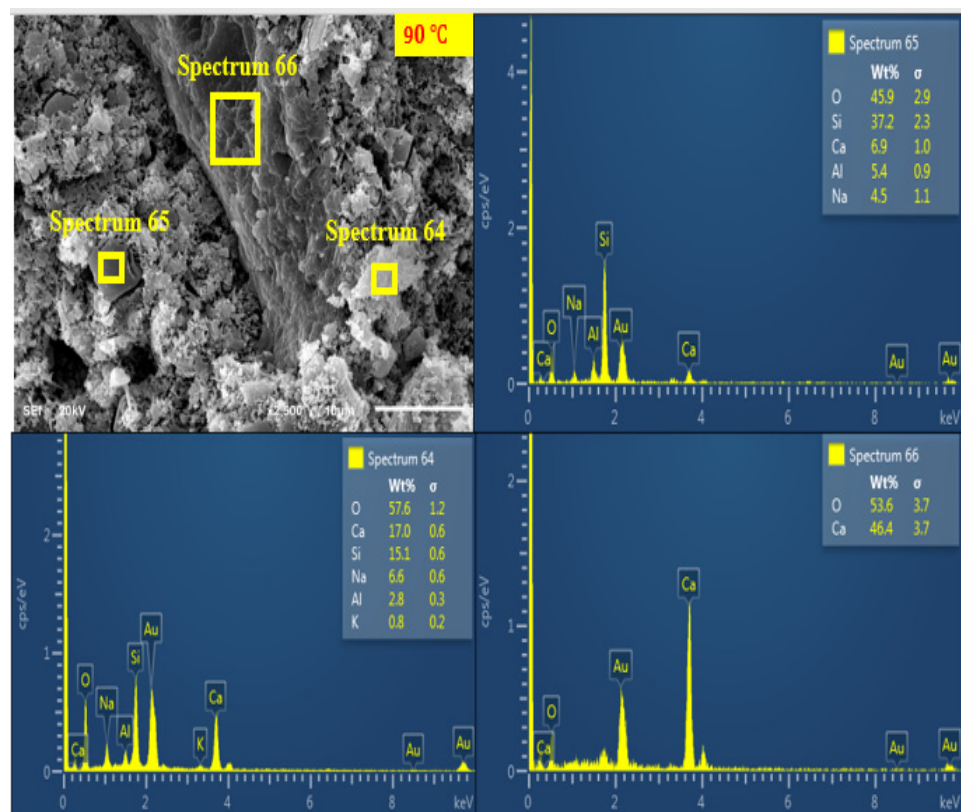
Figure 15. (SEM + EDX) of AANL cured at 7 5℃ .